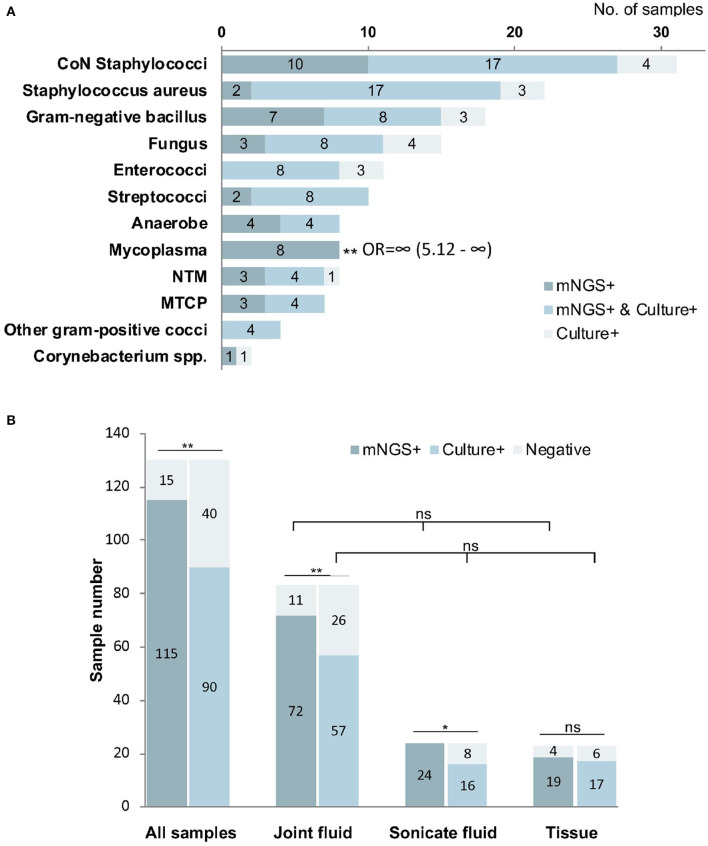
The positivity of metagenomic next-generation sequencing (mNGS) and culture for different pathogens (A) and sample types (B). Mycoplasma were more frequently identified by mNGS than culture (P < 0.01). The overall positive rate of mNGS is significantly higher than that of culture (P < 0.01), especially from joint fluid (P < 0.01) and sonicate fluid (P < 0.05). *P < 0.05; **P < 0.01; mNGS+ and culture+, the results of mNGS and culture were both positive; mNGS+, only the mNGS result was positive, culture was not; Culture+, only the culture result was positive, mNGS was not.